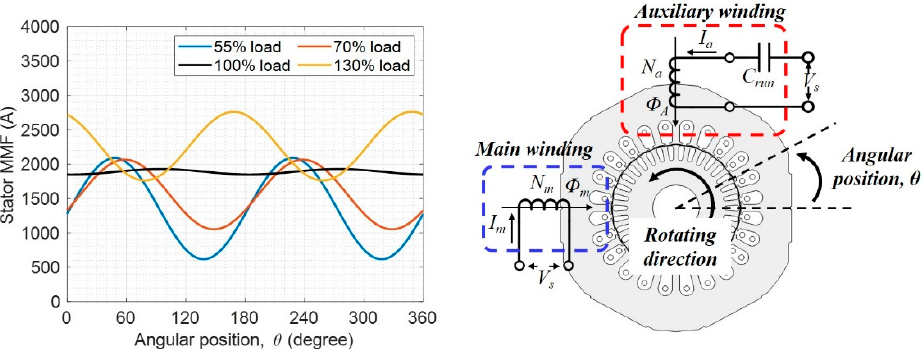
Figure 3. Stator MMF waveform using calculated current in windings under different loads.